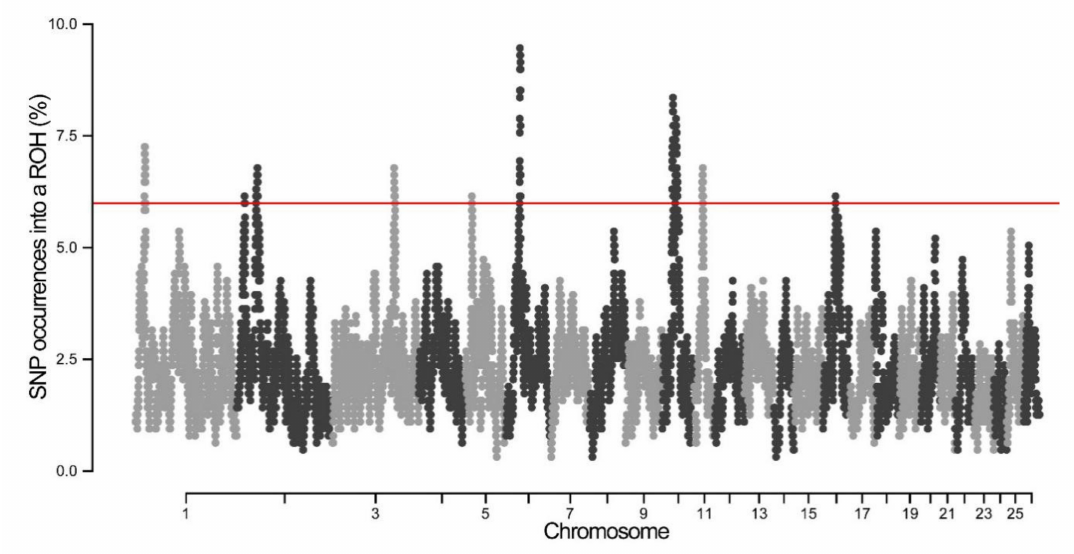
Figure 5. Manhattan plot of the occurrence of single nucleotide polymorphisms (SNPs) in ROH islands across di ff erent